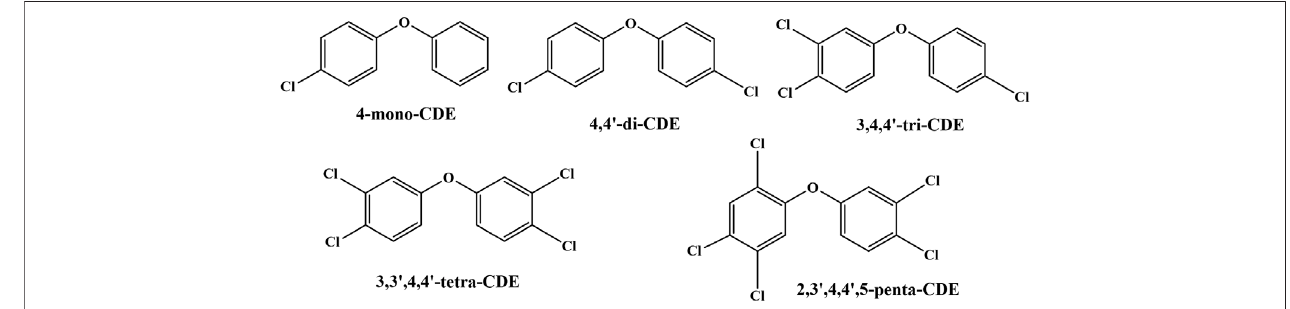
FIGURE 1 | The structures of fi ve tested